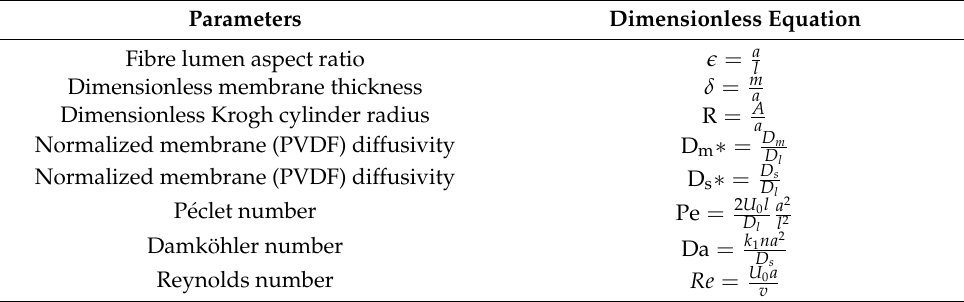
Table 3. Non-dimensional parameters and conversion equations. Parameters Dimensionless Equation Fibre lumen aspect ratio Dimensionless membrane thickness